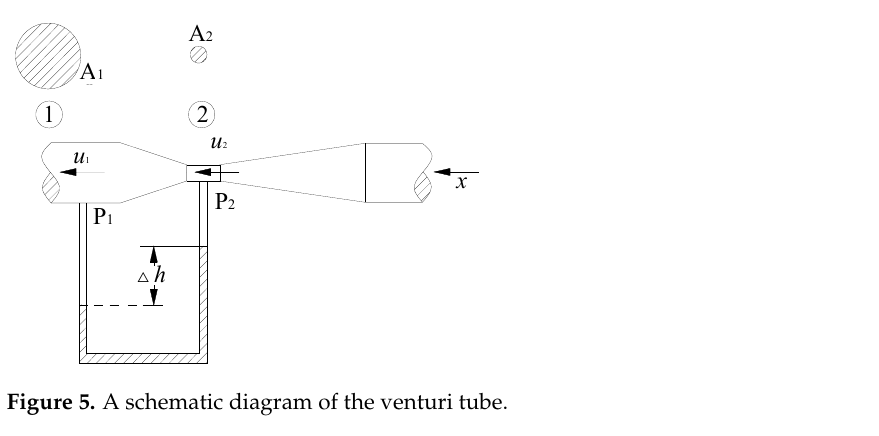
Figure 4. The developed apparatus to measure the gas permeability of pervious concrete: ( a ) schematic outline; ( b ) laboratory setup.